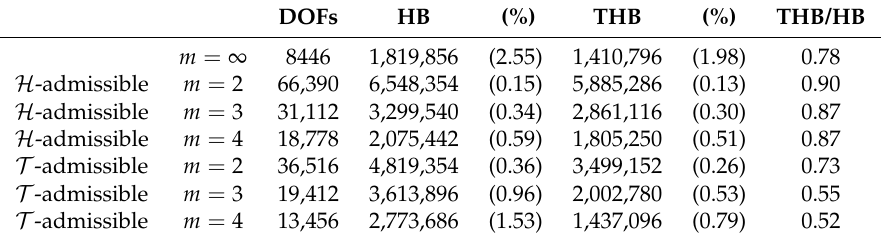
Table 3. Number of nonzeros of the stiffness matrix for p = ( 4,4 )